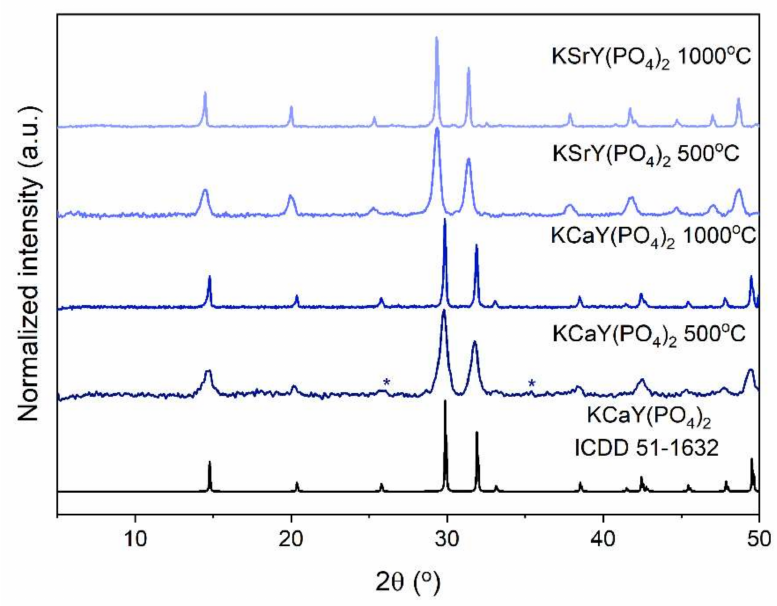
Figure 2. The XRD patterns of samples sintered at different temperatures. Asterisks denote unidenti- fied